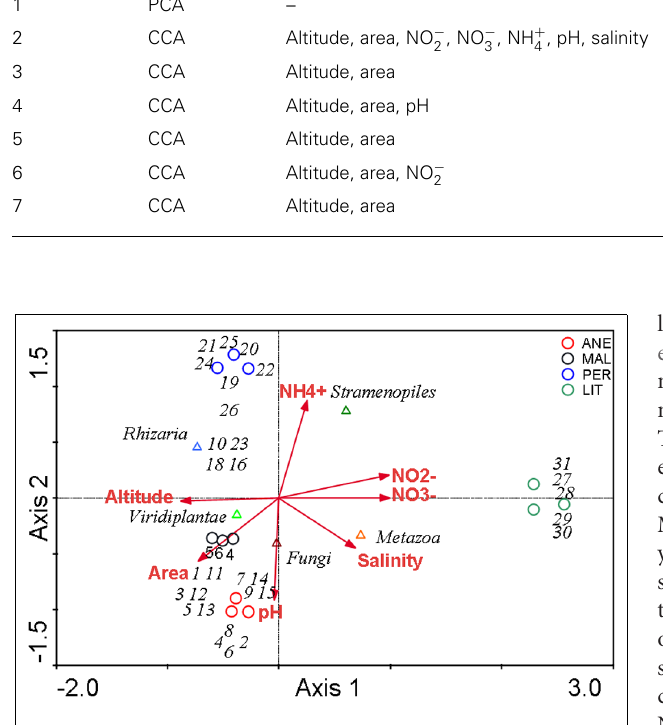
FIGURE 8 | Canonical correspondence analysis. Ordination diagram based on CCA, with respect to seven quantitative variables.The axes are scaled in standard deviation units. Eigenvalues for the axes are detailed in Table 6 .The diagram display triangles that represent phyla, circles representing sampling sites, and arrows that symbolize environmental